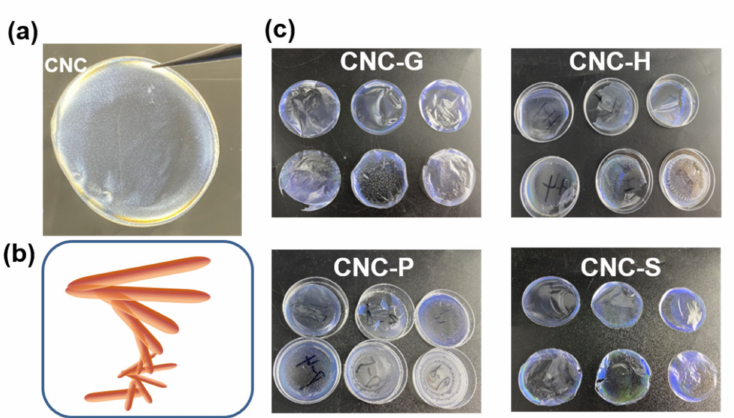
Figure 2. The image of ( a ) pure CNC film under POM, ( b ) model of chiral structure, and ( c ) pho- tographs of CNC (top left) and corresponding composite films with different AA